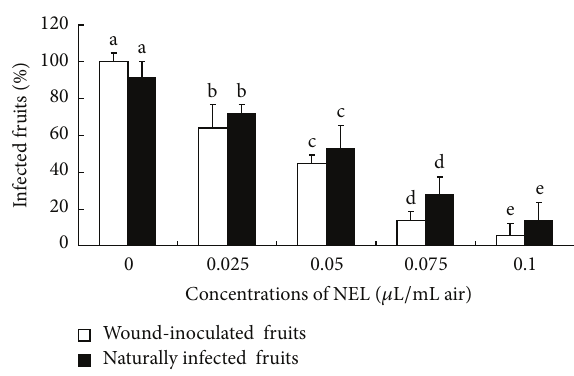
Figure 5: Effects of NEL on fungal development in wound- inoculated cherry tomatoes and naturally infected fruits. Significant differences ( 𝑃 < 0.05 ) between means are indicated by letters above the histogram bars. Values are mean ( 𝑛 = 3 ) ± standard